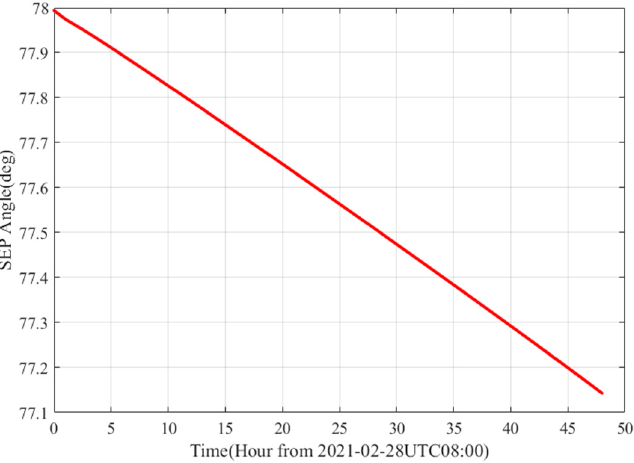
Figure 9. The SEP (Sun–Earth–Probe) of Tianwen-1 during observation period. The second error factor is thermal noise on both the uplink and downlink for the two-way and three-way mode in the Phase-locked-loop situation. As mentioned before, the thermal noise is always modeled as Gaussian white noise, and the error performance 1.21.31.41.51.61.71.81.9 of the proposed method is no more than 1.0102 times that of CRLB when SNR is higher than 0 dB. Therefore, the white noise performance of the Tianwen-1 observation can be evaluated by the CRLB and has also been displayed in Table